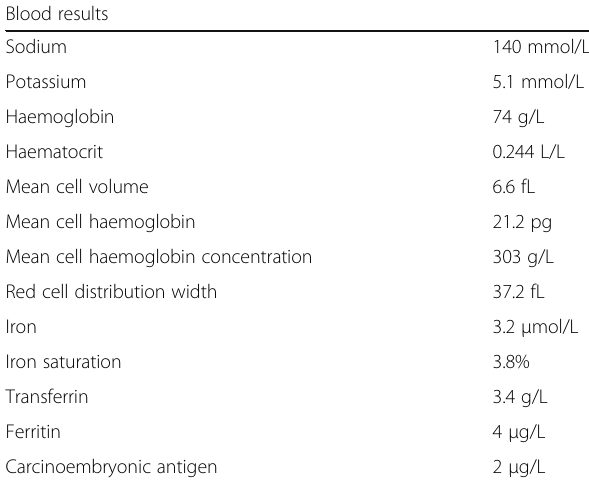
Table 1 Pre-operative blood results Blood results